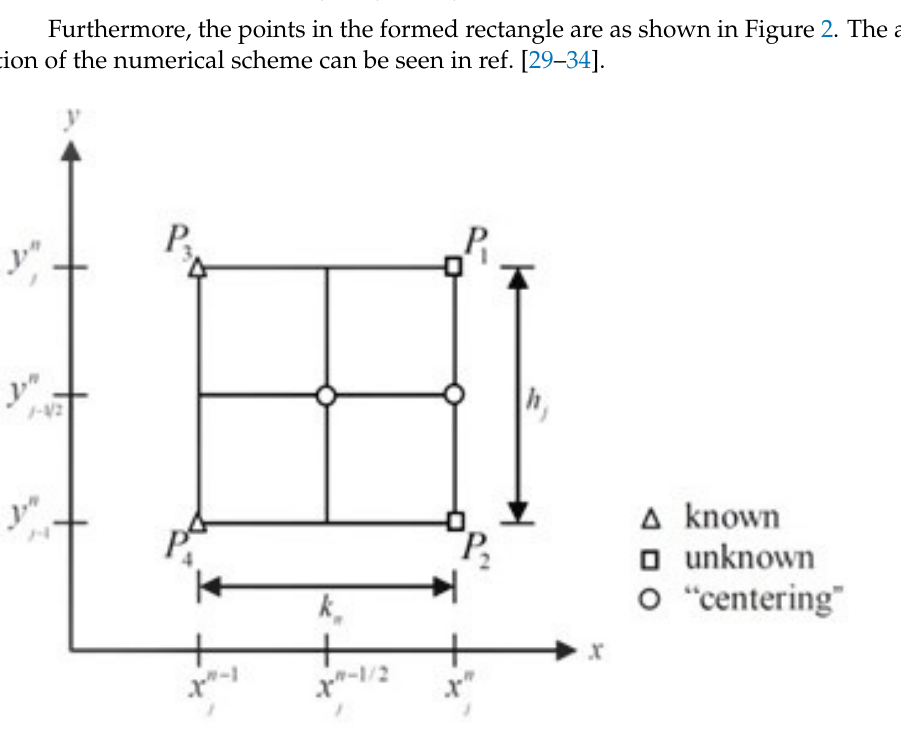
Figure 2. Net rectangle for difference approximation.